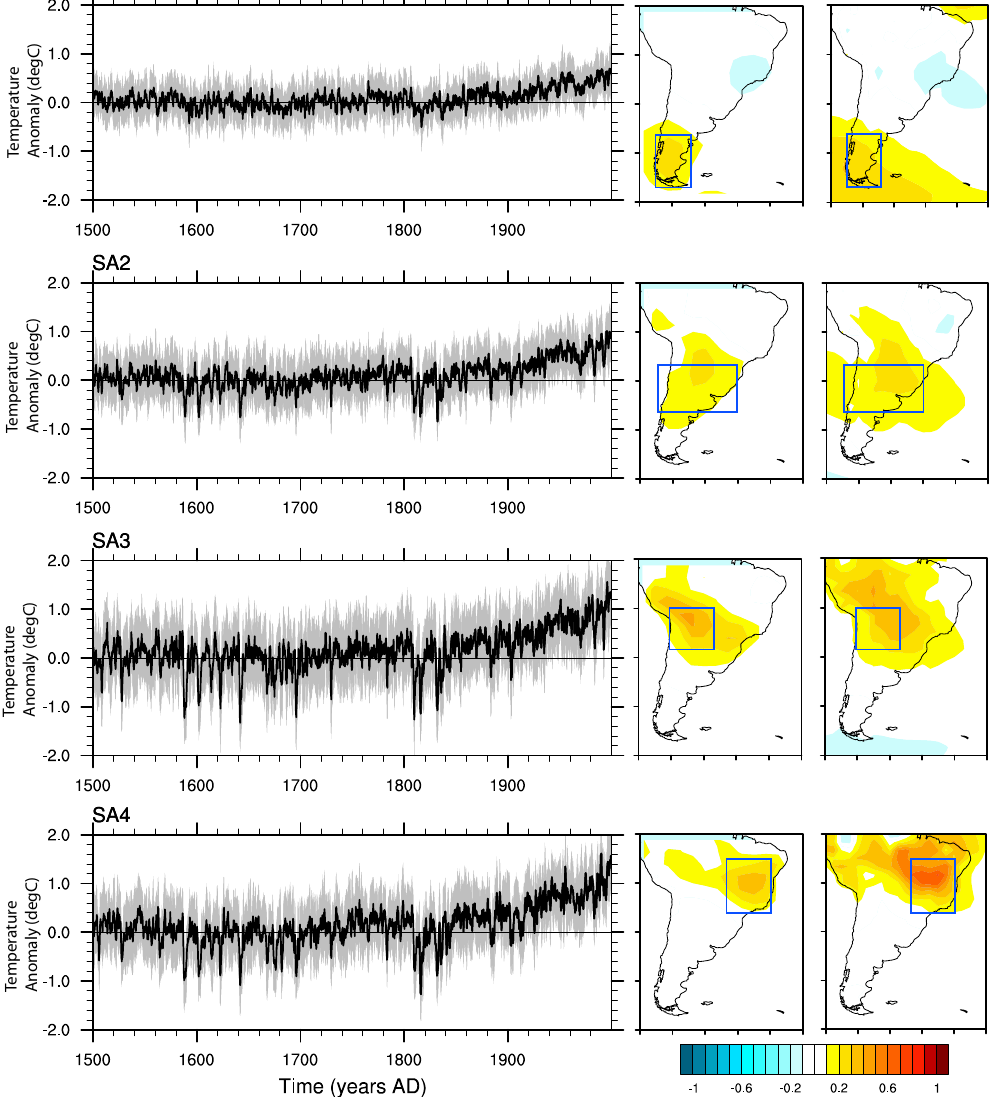
Fig. 5. Time series of the regional monthly temperature anomalies against the pre-industrial mean smoothed with a 12-month running mean for illustrative regions in South America. The ensemble mean is shown in black and the one standard deviation range in grey. The correlation pattern of the respective regional temperature index with the spatial temperature pattern together with the selected region (blue box) is shown for both CTRL1990 (left maps) and ERA-40 (right maps).